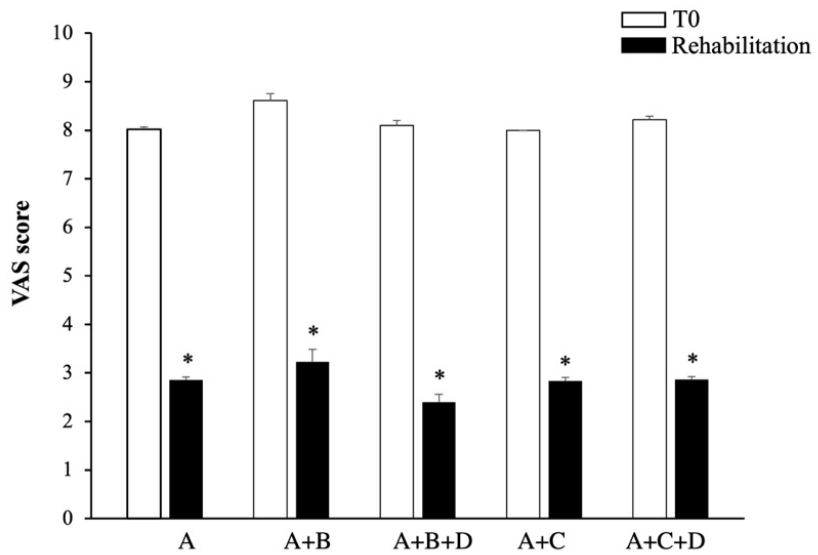
Figure 8. Pain intensity as visual analog scale (VAS) score before (T0) and after (T1) the different rehabilitation paths. * p < 0.05 compared with T0.